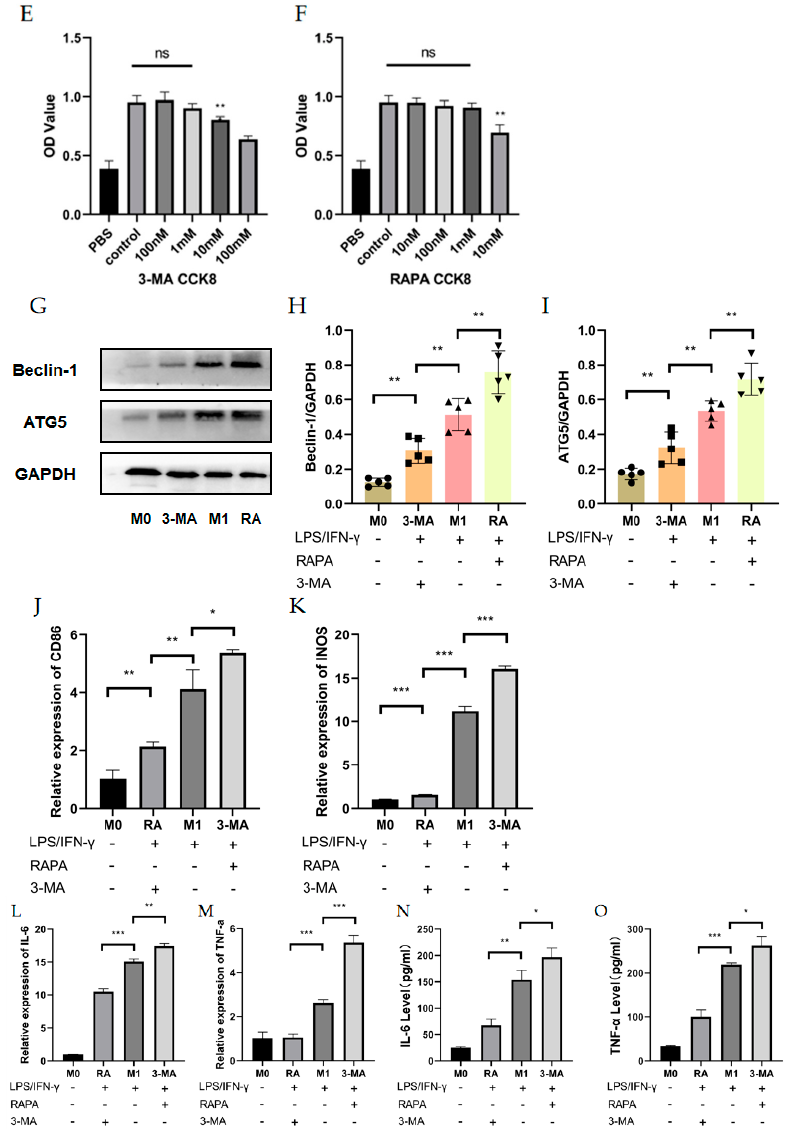
Figure 3. Effects of autophagy levels on macrophage polarization and inflammation-related cytokines. ( A – D ) The mRNA expression of M1 macrophage markers (CD86 and INOS) and M2 macrophage markers (CD163 and CD206) were analyzed by RT-qPCR in M0 macrophages after RAPA (100 nM) or 3-MA (1 mM) treatment. n = 6:6. ( E , F ) The cell viability of THP-1 cells after pretreatment with RAPA (10 nM, 100 nM, 1 mM, 10 mM) and 3-MA (100 nM, 1 mM, 10 mM, 100 mM) for 4 h analyzed by CCK8 assay. n = 6:6. ( G ) The changes in Beclin-1 and ATG5 protein expression in M0 group, RAPA group, M1 group, and 3-MA group analyzed by Western blot. n = 5:5:5:5. ( H , I ) Quantification of the Western blot result for Beclin-1 and ATG5 in ( G ). ( J , K ) The mRNA expression of CD86 and